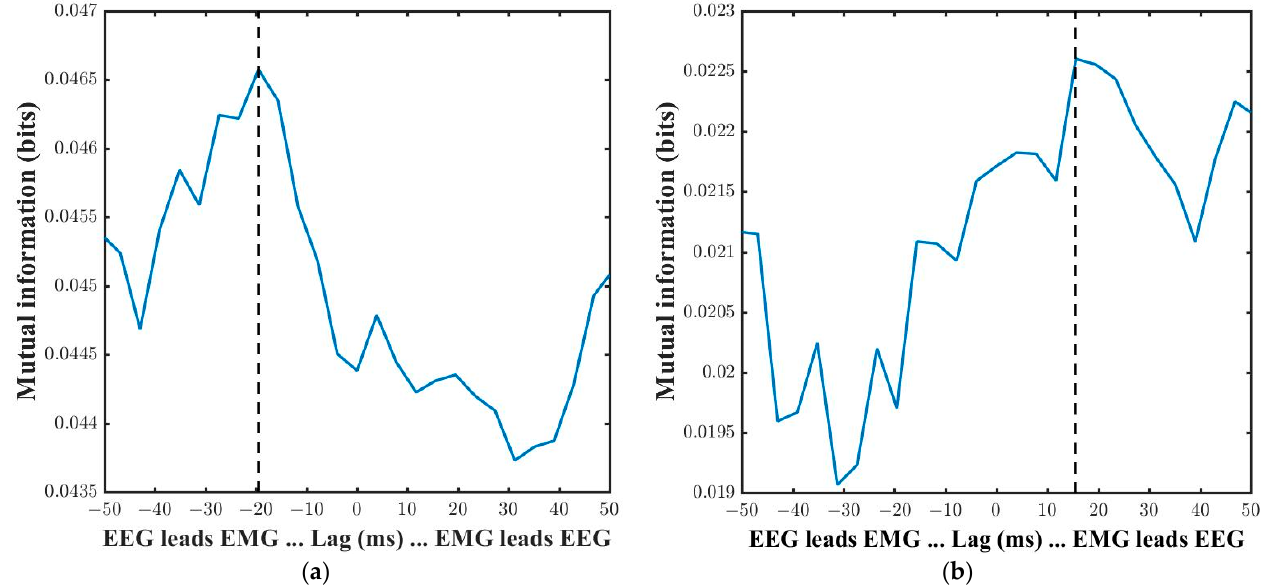
Figure 11. Delay time mutual information of one subject in RM task: ( a ) in beta band; ( b ) in gamma band. The black vertical dotted line represents the delay time at the maximum value of mutual information.